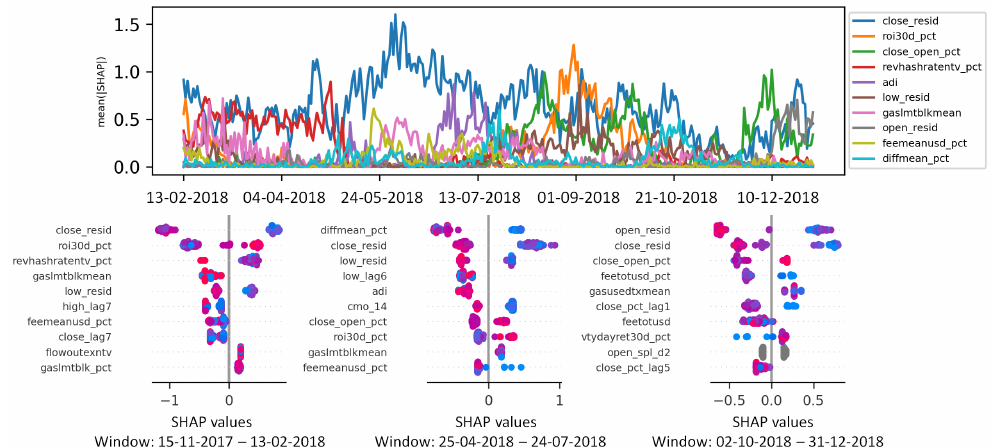
Figure 10. Interactive dashboard snapshot. Uptrend class. ETHUSD. Sliding training window size W =